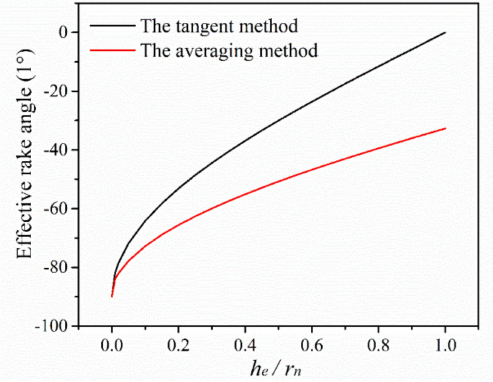
Figure 2. The e ff ective rake angle varies with the ratio of h e / r n